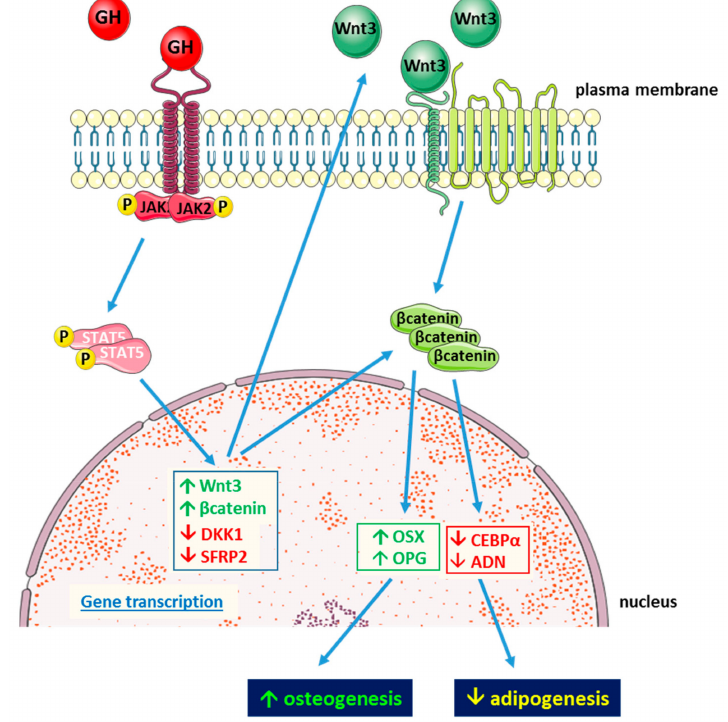
Figure 2. Schematic representation of antiadipogenic action of GH in human mesenchymal stem cells (MSCs) derived from trabecular bone (blue arrows indicate related e ff